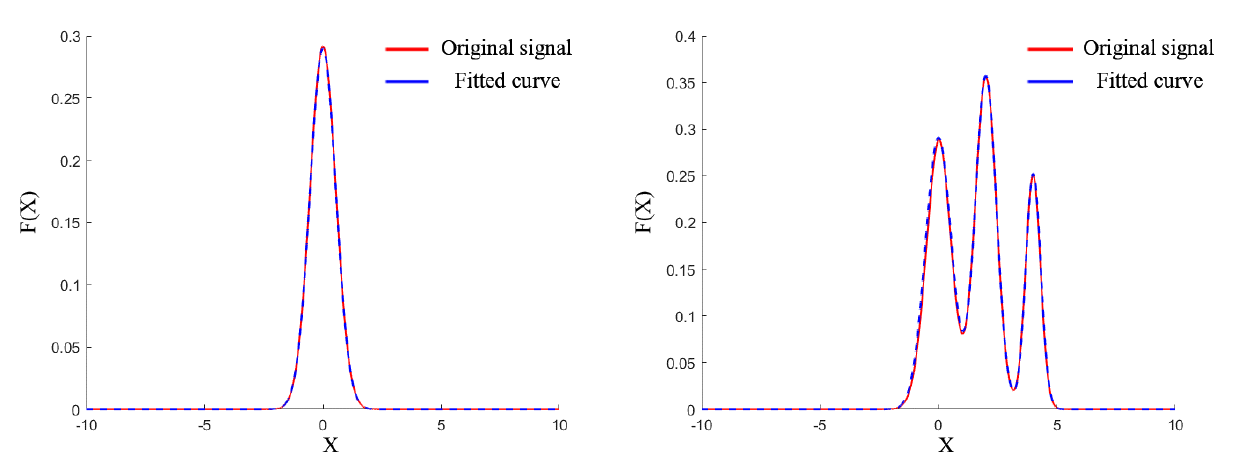
Figure 8. Fitting effect of the proposed